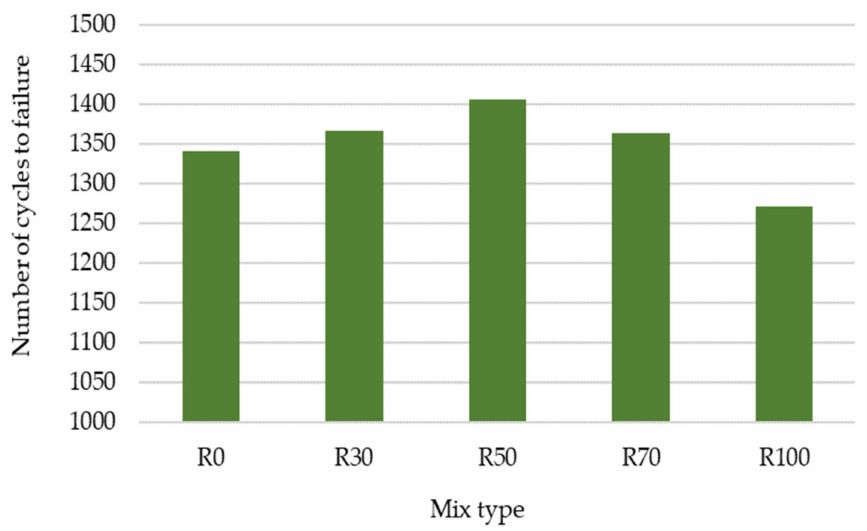
Figure 5. Fatigue results for the five